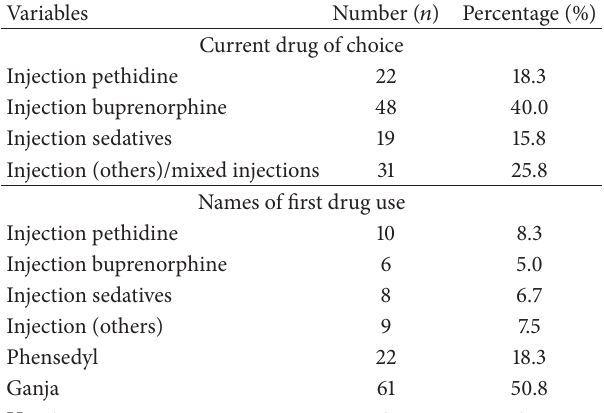
Table 2: Distribution of respondents by drug use ( 𝑛 = 120 ). Table 3: Distribution of respondents by health seeking behavior ( 𝑛 = 120